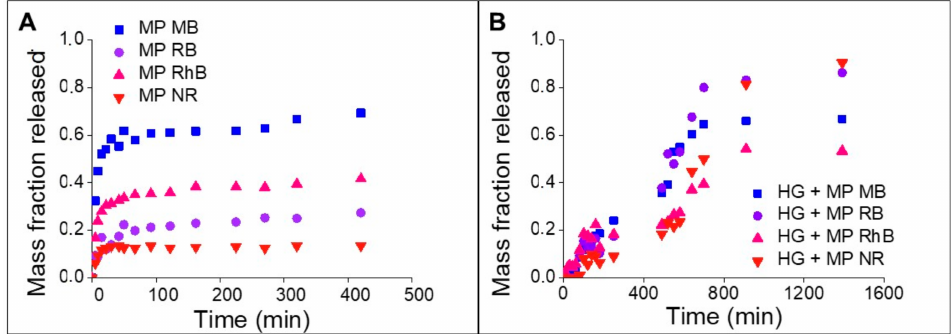
Figure 8. Release kinetics. ( A ) SF microparticles loaded with dyes. ( B ) SF hydrogels containing the microparticles loaded with